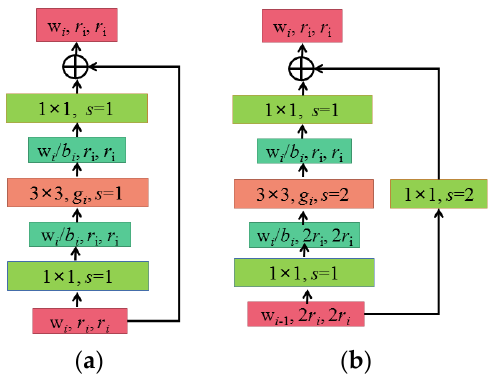
Figure 3. Structural framework of the block: ( a ) X block, s = 1; ( b ) X block, s = 2.